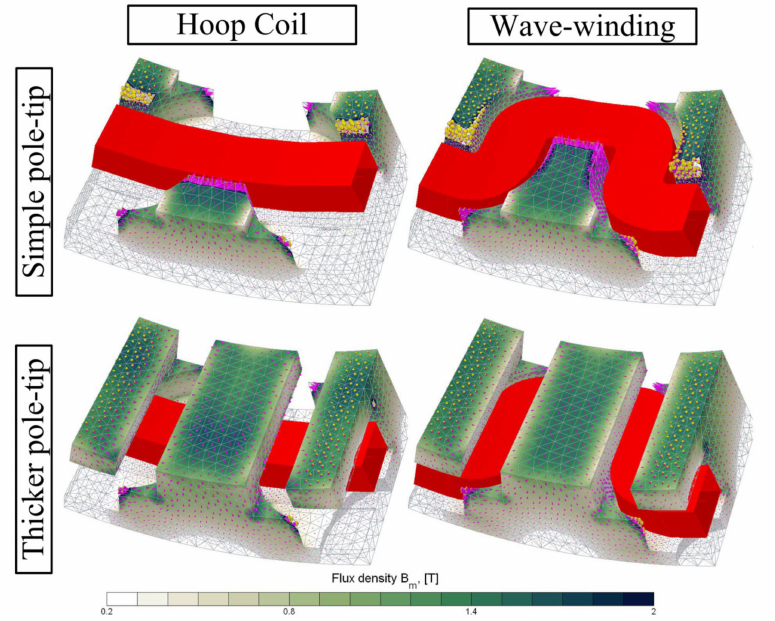
Figure 28. Comparison between hoop coil (Transversal flux configuration) and wave windings (Radial- to-transversal flux configuration) for a claw-pole machine with different pole-tip thicknesses